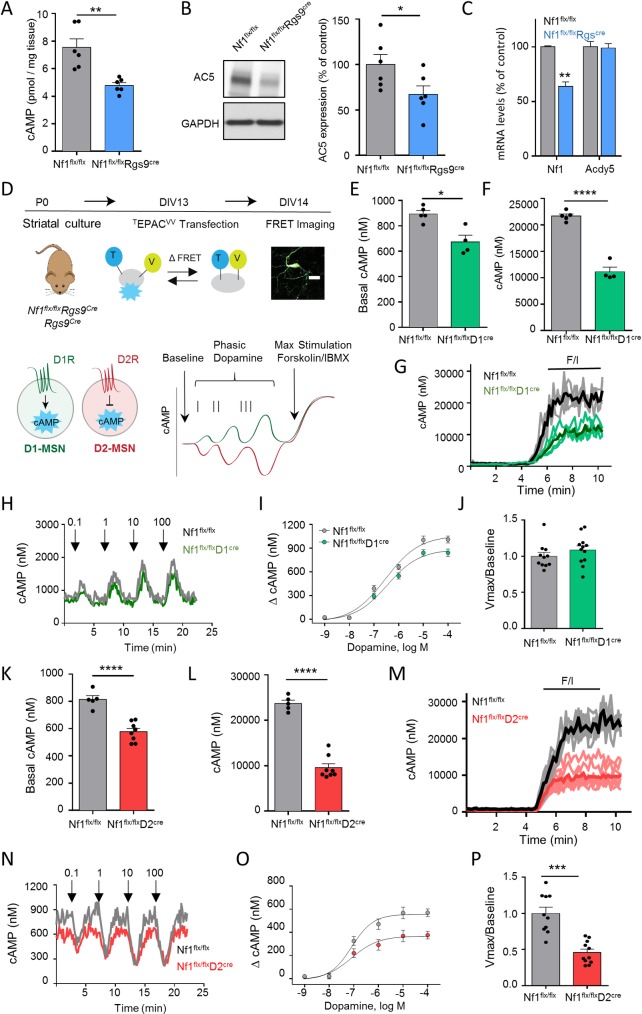
Cell-specific effects of NF1 on cAMP signaling in the striatum.(A) Quantification of total striatal cAMP in Nf1flx/flx and Nf1flx/flxRgs9Cre mice. n = 6 mice/group, Student t test. (B) Representative image of western blot analysis for AC5 expression in the striatum of Nf1flx/flx and Nf1flx/flxRgs9Cre mice. n = 6 mice/group. Student t test. (C) Comparison of mRNA for Nf1 and Adcy5 in striatum of Nf1flx/flx and Nf1flx/flxRgs9Cre mice. n = 6 mice/group. Student t test. (D) Scheme and Image of TEPACVV fluorescence in transfected primary MSNs. Mouse graphic was adapted from [44]. Scale bar represents 20 μm. Quantification of baseline striatal cAMP levels for (E) Nf1flx/flxD1Cre and (K) Nf1flx/flxD2Cre compared with Nf1flx/flx mice. n ≥ 4 neurons/genotype. Change in cAMP following bath application of forskolin/IBMX to (F) D1R-MSNs and (L) D2R-MSNs. n ≥ 4 neurons/genotype. Quantification of maximum cAMP change following forskolin/IBMX treatment for (G) Nf1flx/flxD1Cre and (M) Nf1flx/flxD2Cre neurons. n ≥ 4 neurons per genotype. Representative traces of cAMP dynamics for (H) Nf1flx/flxD1Cre and (N) Nf1flx/flxD2Cre to a 1-second pulse of dopamine at the indicated micromolar concentration. Quantification of maximum change in cAMP response to phasic dopamine pulses for (I) Nf1flx/flxD1Cre and (O) Nf1flx/flxD2Cre neurons. Discrimination ratio (Vmax/Baseline) for cAMP response to dopamine in (J) Nf1flx/flxD1Cre and (P) Nf1flx/flxD2Cre. n ≥ 4 neurons per genotype, Kolmogorov-Smirnov test. *P < 0.05, **P < 0.01, ***P < 0.001. Data are represented as mean ± SEM. Underlying data for this figure can be found in S1 Data. AC5, adenylyl cyclase type 5 (protein); Adcy5, adenylyl cyclase type 5 (gene); D1R, D1 dopamine receptor; D2R, D2 dopamine receptor; IBMX, 3-isobutyl-1-methylxanthine; MSN, medium spiny neuron; NF1, neurofibromin 1.